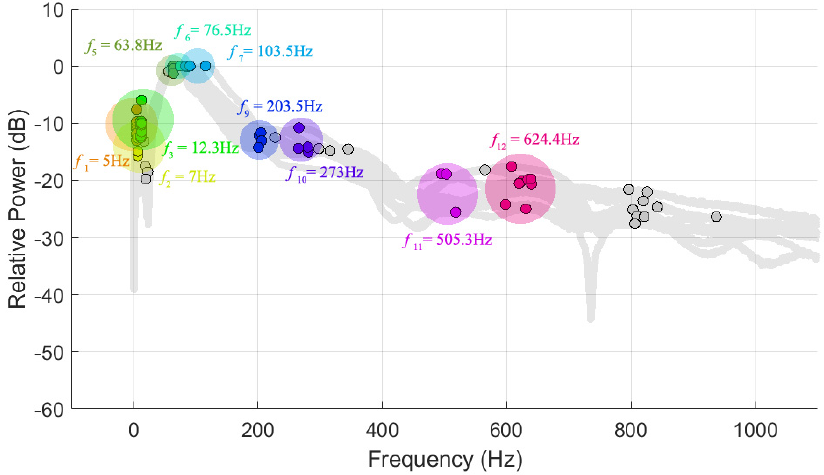
Figure 2. Schematic of the mode clusters using DBSCAN projected in two-dimensional space of a leg frequency response.